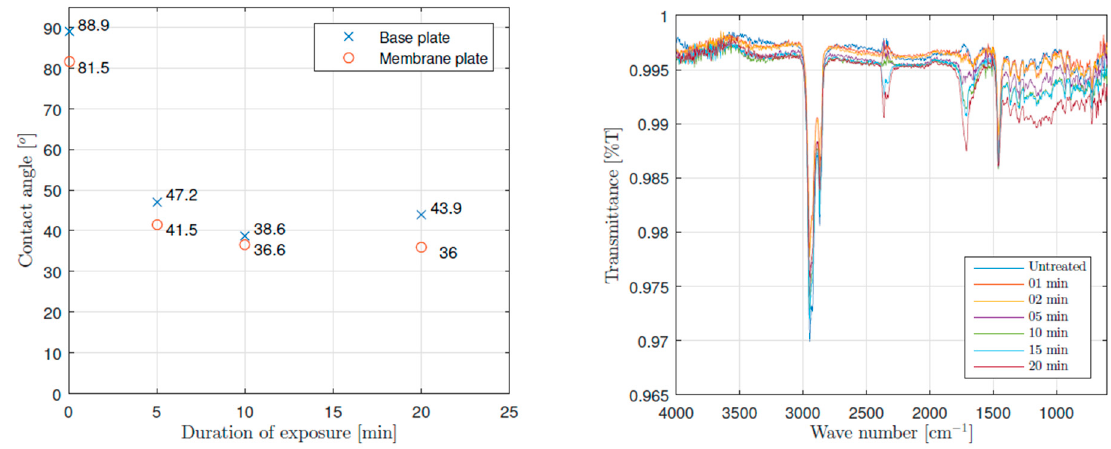
Figure 1. ( a ) Water contact angles for base (COC) and membrane plate (eCOC), and ( b ) ATR-IR spectra of COC for different UV/ozone exposure times.